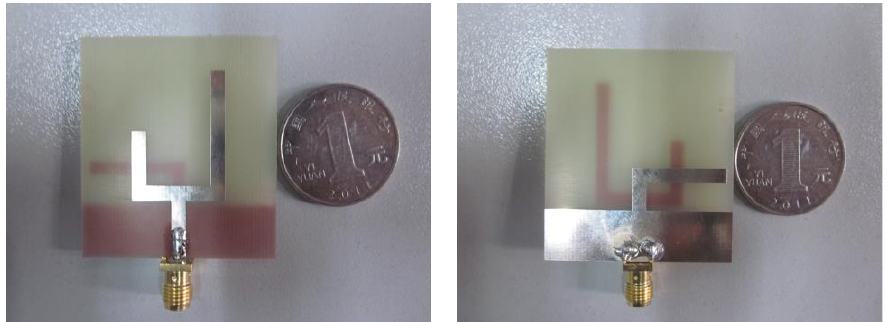
Figure 11. The physical picture of the proposed antenna.